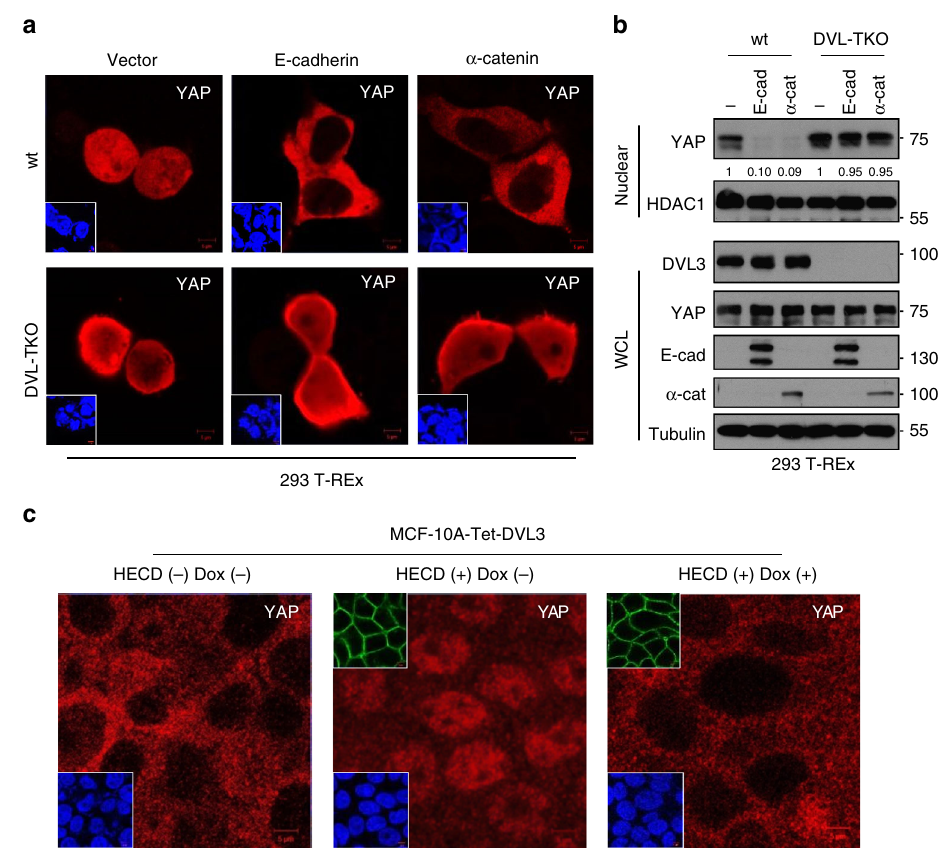
Fig. 5 DVL is required for cytoplasmic traf fi cking of YAP induced by E-cadherin or α -catenin. a The wt and DVL-TKO 293 T-REx cells were transfected with fl ag-tagged YAP (50 ng) in combination with vector control (1 μ g) or E-cadherin (1 μ g) or α -catenin (1 μ g), and YAP localization was determined by confocal microscopy. Inset, DAPI nuclear stain; Scale bar, 5 μ m. b The wt and DVL-TKO 293 cells were transfected with vector control ( − ) or E-cadherin (E-cad) or α -catenin ( α -cat), and endogenous YAP abundance in nuclear fraction and whole-cell lysates (WCL) was determined by immunoblot analysis. Relative nuclear YAP abundance compared to control was measured by ImageJ. c The MCF-10A cells were cultured under con fl uent contact inhibition and intracellular YAP localization was monitored by confocal microscopy. The cells were incubated with a mouse IgG (HECD-) or a neutralizing monoclonal antibody (HECD, 10 μ g/ml) that disrupts homophilic binding of E-cadherin for 16 h. Immuno fl uorescence images showing YAP staining of MCF-10A cells having tetracycline-inducible DVL3 in the absence (Dox-) or presence (Dox + ) of doxycycline. Upper inset, HECD antibody detected by fl uorescent- conjugated secondary antibody; lower Inset, DAPI nuclear stain; Scale bar, 5 μ m. Unprocessed original scans of blots are shown in Supplementary Fig.